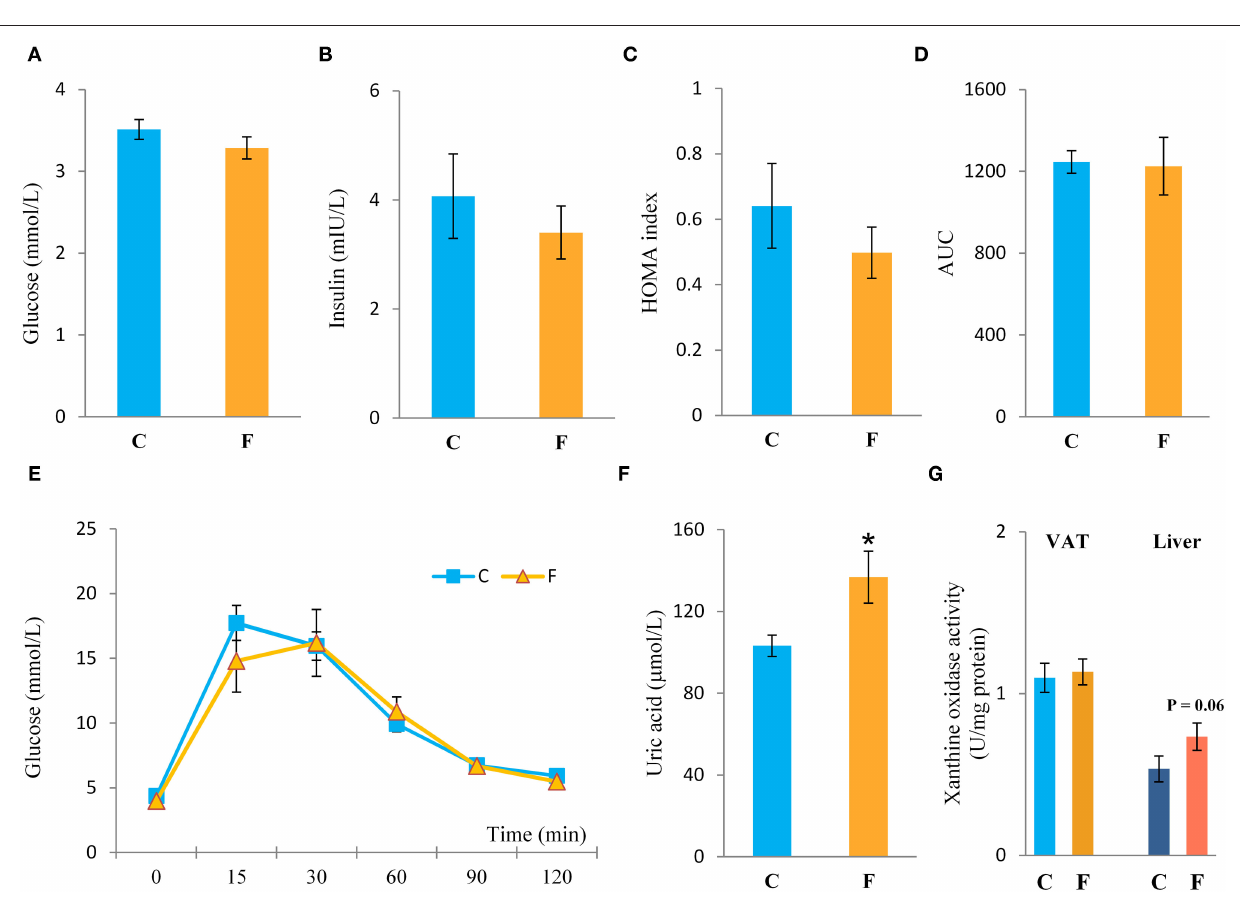
FIGURE 3 | Systemic insulin sensitivity in female rats fed with 10% fructose diet for 9 weeks. (A) Blood glucose level, (B) plasma insulin level, (C) homeostasis model assessment (HOMA) index, (D) AUC values, (E) intraperitoneal glucose tolerance test (IPGTT), (F) plasma uric acid level, and (G) activity of xanthine oxidase in VAT and liver were determined in the control (C) and fructose-fed (F) female rats. The values represent the mean ± SEM ( n = 8 animals per group). Statistical significance of between-group differences (Student’s t -test): * P < 0.05, F vs.